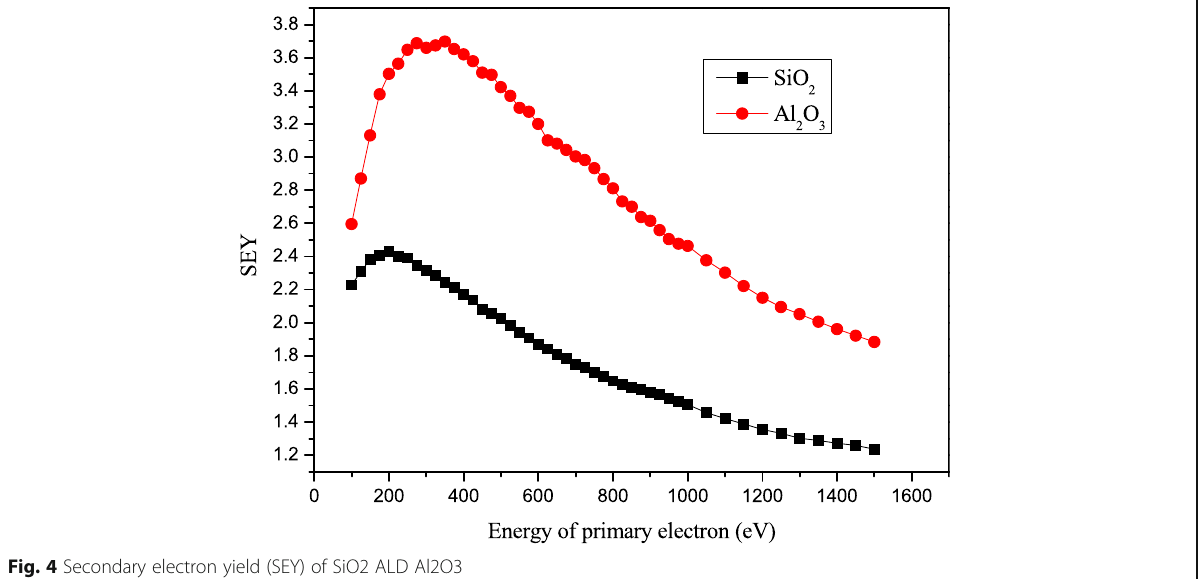
Fig. 4 Secondary electron yield (SEY) of SiO2 ALD Al2O3